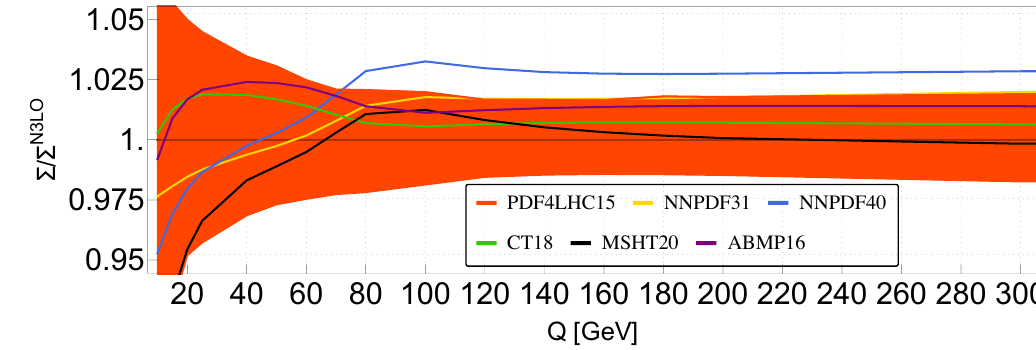
Figure 14. Dependence of the NCDY process at N 3 LO on the choice of the PDF set relative to the combined PDF4LHC15_nnlo_mc set. The red band corresponds to the δ ( PDF ) uncertainty.